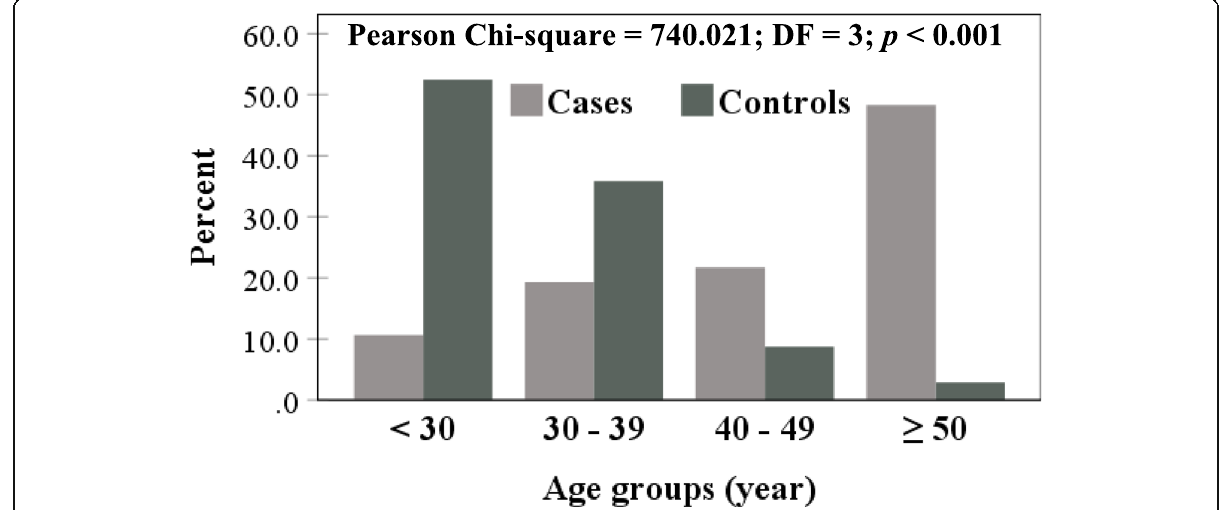
Fig. 5 COVID-19 cases and control distributed according to age